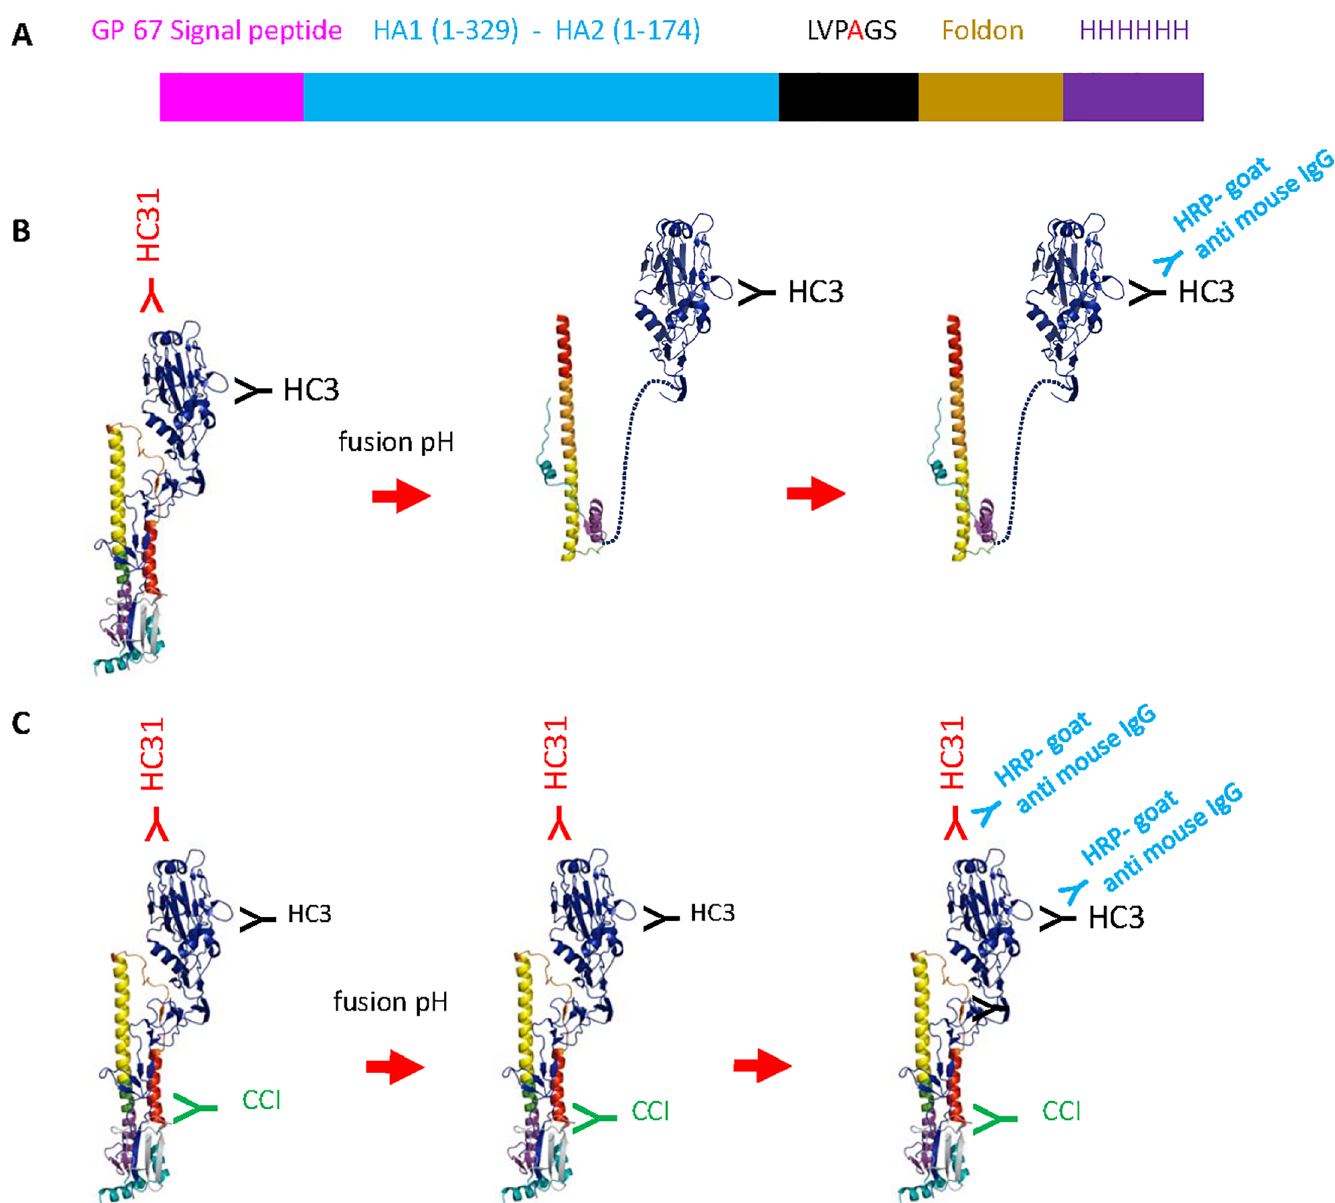
Fig 1. Principle of HCCIA. A. The linear schematic of the rHA as described [41] with some modifications, not to scale. N-terminal baculovirus GP67 signal peptide, HA ectodomain, mutated thrombin cleavage site from LVPRGS to LVPAGS, foldon, and 6 histidine-Tag. B. The structure shown in the schematic was modified from a published HA structure (PDB No. 1HTM and 4WE4) [41–43]. Though trimeric rHA was used in the HCCIA, the H3 rHA is shown as a monomer in Fig 1. In the absence of CCI, H3 rHA would undergo conformational changes at the pH of fusion and HC31 (HC67 for H3 rHA, or 1/87 mAb for H2 rHA) would lose the ability to bind to the rHA, while HC3 (shown in black) would bind to the H3 rHA when in its fusogenic conformation. C. In the presence of CCI (shown in green), H3 rHA would remain “locked” in its metastable pre-fusion conformation and maintain recognition by both HC3 (shown in black) and HC31 (shown in red), as well as HC67 or 1/87 mAb for H2